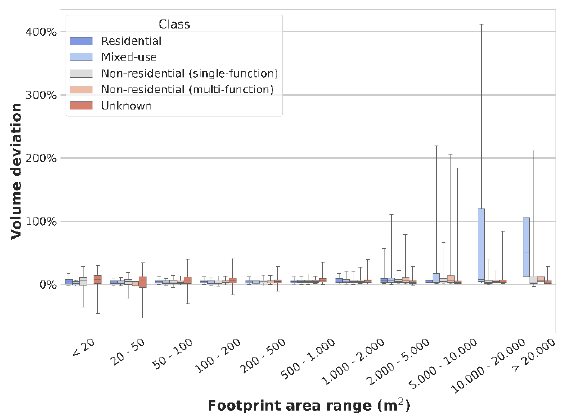
Figure 10. Distribution of volume differences (in %) between the LoD22 and nDSM models based on the footprint size and building function. Top and bottom whiskers correspond to the 95 th and 5 th percentile, respectively.